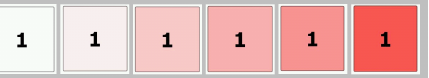
animated figure showing the